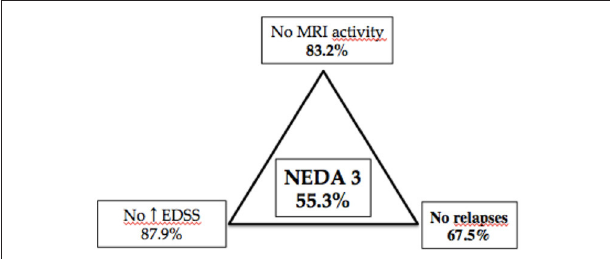
FIGURE 2 | Different components of NEDA 3 status at 24-month follow-up in 340 patients with MS treated with dymethilfumarate.